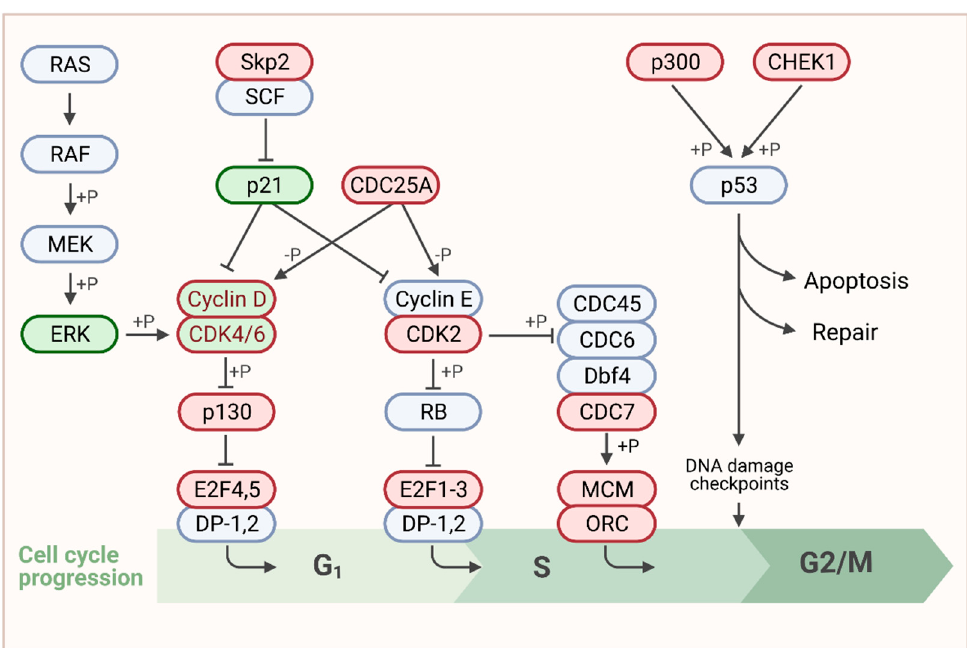
Figure 3. Association of MSI1 expression with cell cycle related genes. Schematic representation of the G1/S focus part of the KEGG: cell_cycle pathway according to (https://www.genome.jp/, accessed on 30 March 2021). For the entire pathway please refer to Supplementary Materials, Figure S1. Published MSI1 target transcripts are depicted in green. Genes that were positively correlated to MSI1 in more than 50% of cancer entities are shown in red. Genes that belong to both categories are shown in dual color. Created with www.BioRender.com, accessed on 31 March 2021.